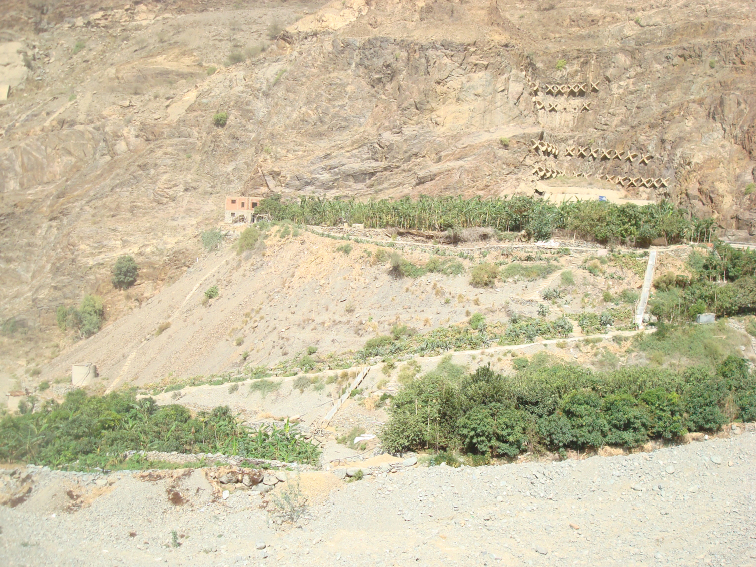
Type locality, Al Bahah, Mukhwah Aqaba RD. (photo M. R. Sharaf).